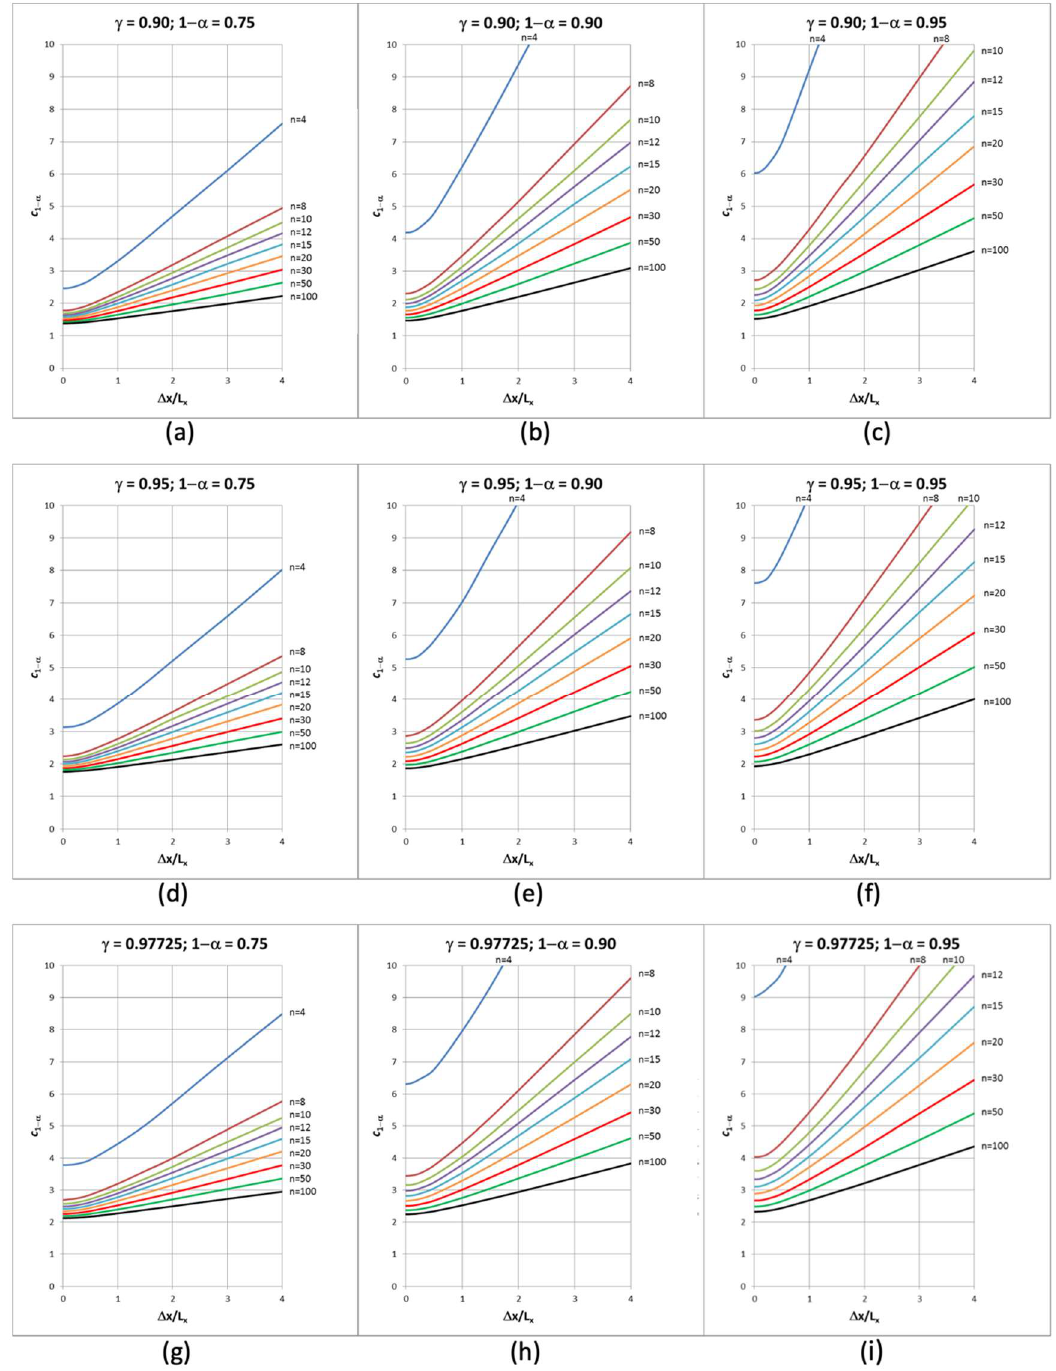
Figure 2. Factor c 1 − α for nine different combinations of tolerance γ and confidence level 1 − α : ( a ) γ = 0.9 and 1 − α = 0.75; ( b ) γ = 0.9 and 1 − α = 0.90; ( c ) γ = 0.9 and 1 − α = 0.95; ( d ) γ = 0.95 and 1 − α = 0.75; ( e ) γ = 0.95 and 1 − α = 0.90; ( f ) γ = 0.95 and 1 − α = 0.95; ( g ) γ = 0.97725 and 1 − α = 0.75; ( h ) γ = 0.97725 and 1 − α = 0.90; ( i ) γ = 0.97725 and 1 − α = 0.95. The meaning of the axis is explained in Figure 1.